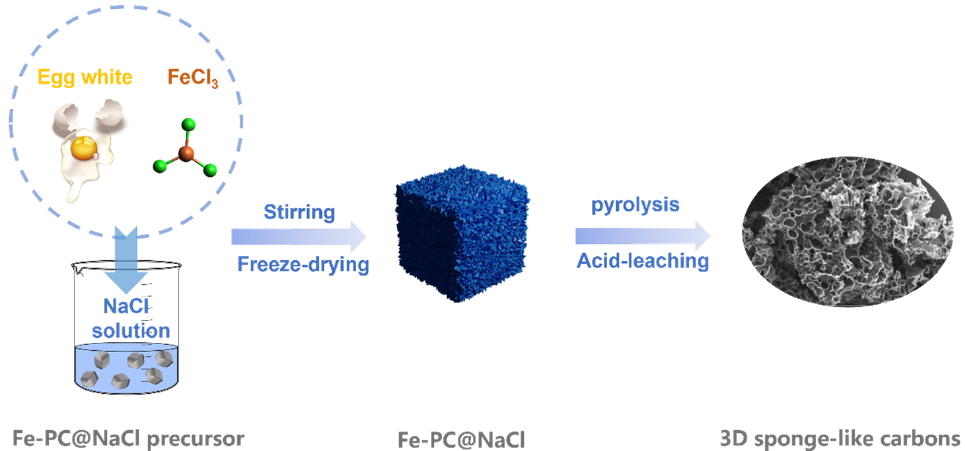
Figure 1. A schematic diagram of three-dimensional sponge-like